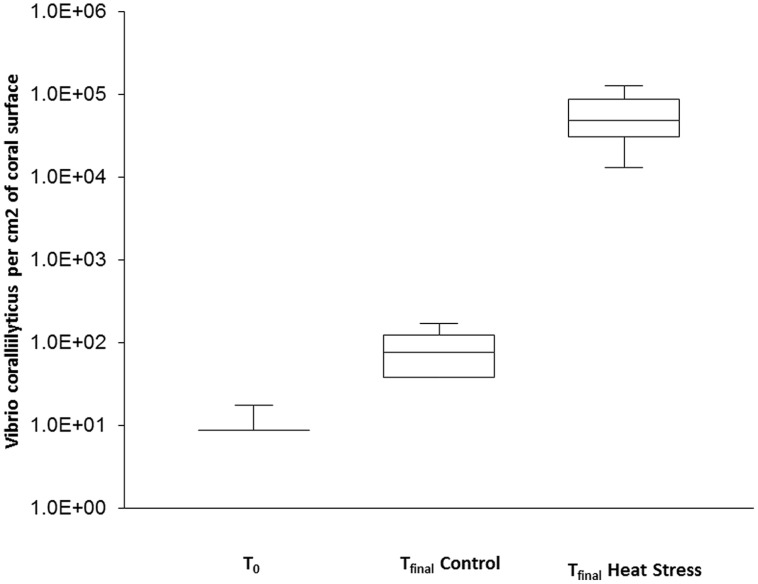
Quantitative PCR assays were used to quantify the abundance of natural populations of Vibrio coralliilyticus associated with the coral P. damicornis on Heron Island, the Great Barrier Reef at t0 (22°C), tfinal Control (22°C), and tfinal Heat stress (31°C) conditions, standard curve: R2 = 0.995, Eff% = 99.9. Abundances are expressed as the number of bacteria per cm2. n = 3.